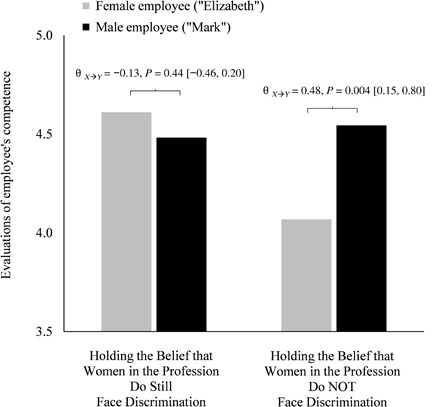
Evaluations of employee competence (general measure) by the purported gender of the target employee and managers’ beliefs about whether women in their profession still face discrimination.Scale is 1 to 7 (n = 236); higher values indicate higher competence evaluations. Among managers who believe discrimination against women is no longer an issue, the male employee was evaluated as more competent than the otherwise identical female employee. Analyses probed the interaction (by managers’ beliefs) at ±1 SD. These values correspond to a general endorsement/rejection of these beliefs. For ease of interpretation and because the values represent categorically distinct beliefs, they are presented as bars (estimated means at ±1 SD with covariates at their sample means). The differences in means correspond to the following values: “Holding the Belief that Women in the Profession Do Still Face Discrimination,” θX➔Y = −0.13, SE = 0.17, P = 0.44 [−0.46, 0.20]; “Holding the Belief that Women in the Profession Do NOT Face Discrimination,” θX➔Y = 0.48, SE = 0.17, P = 0.004 [0.15, 0.80]. For an analogous depiction with the above confidence intervals (around the conditional effect of target gender, θX➔Y | M), see fig. S2.